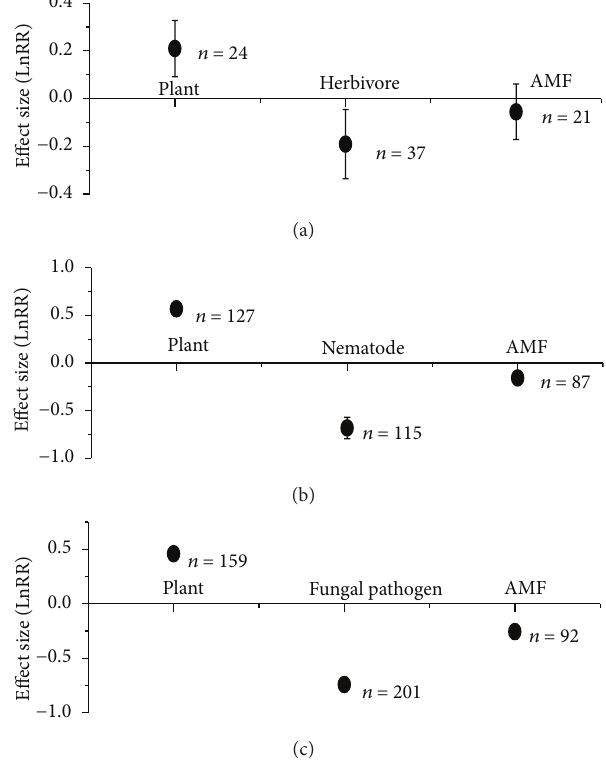
with 95% CIs: −0.74 with −0.81∼− 0.68; −0.26 with −0.33∼